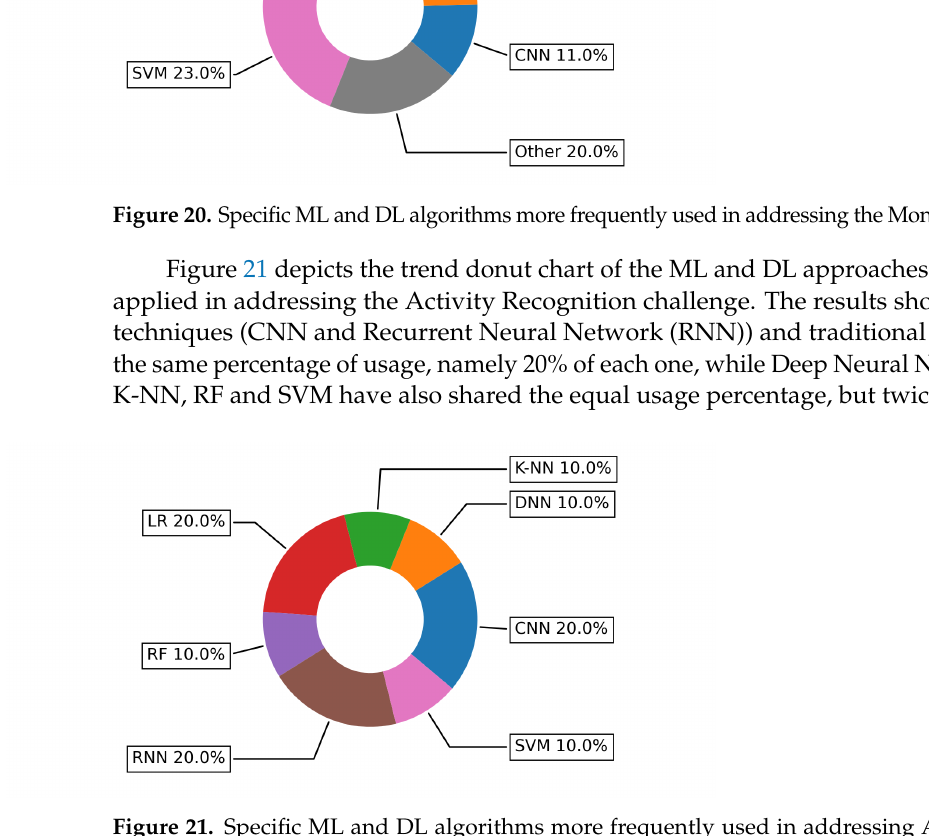
Figure 21. Specific ML and DL algorithms more frequently used in addressing Activity Recogni- tion